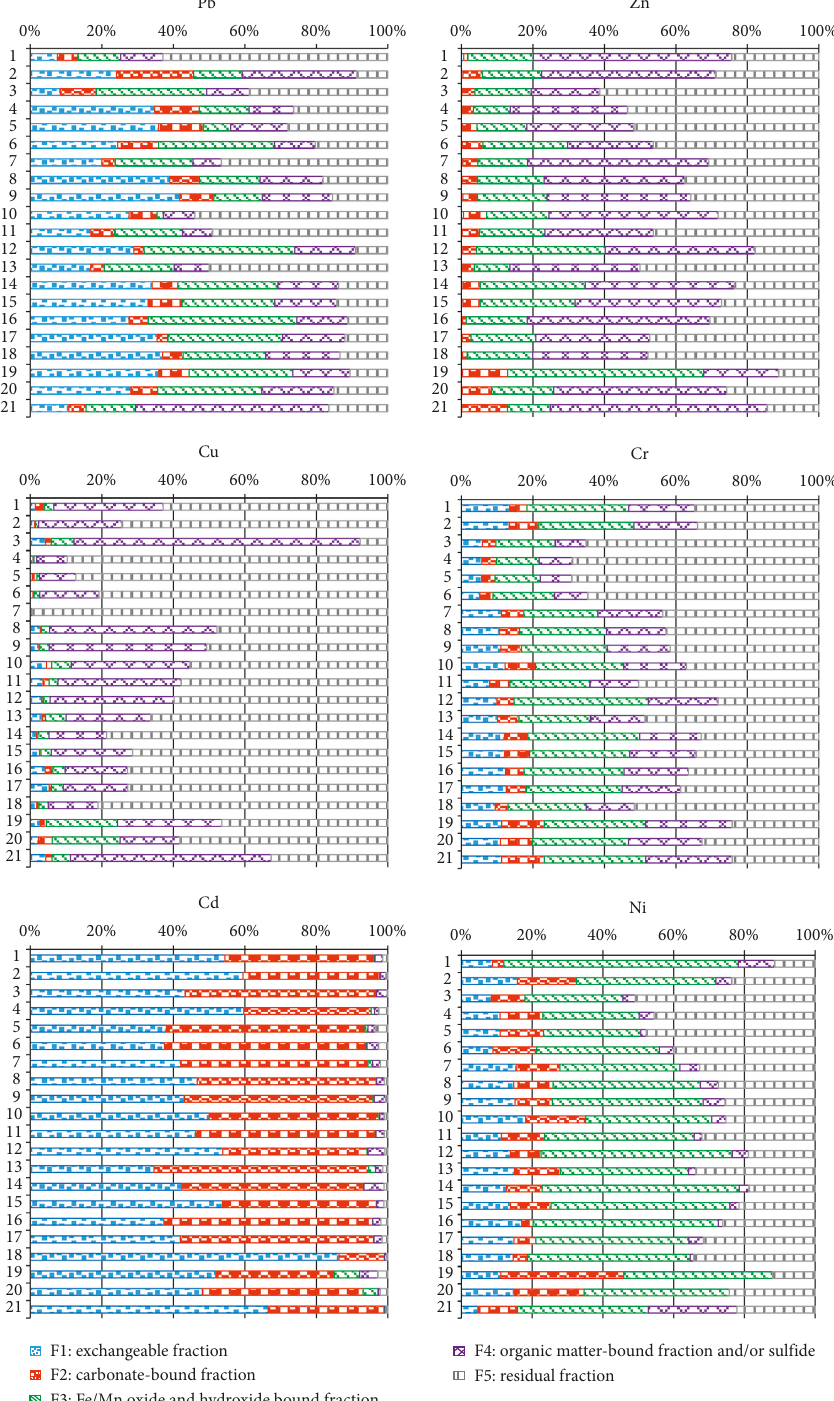
Figure 3: Chemical speciation of Pb, Zn, Cu, Cd, Cr, and Ni (in